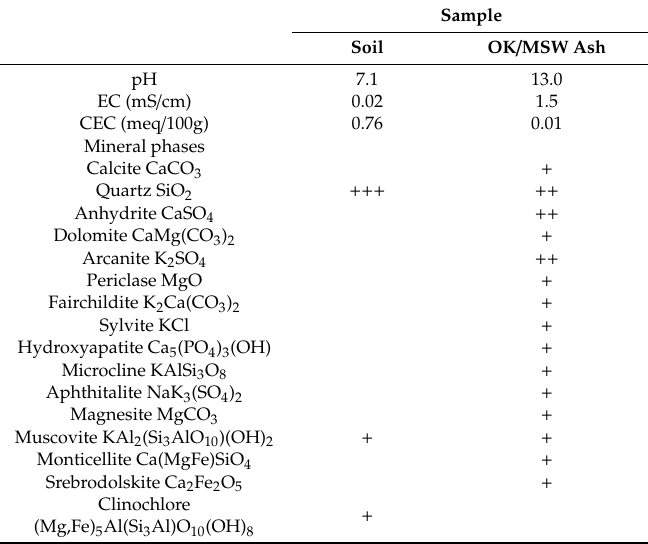
Table 1. Physical and chemical properties of soil and